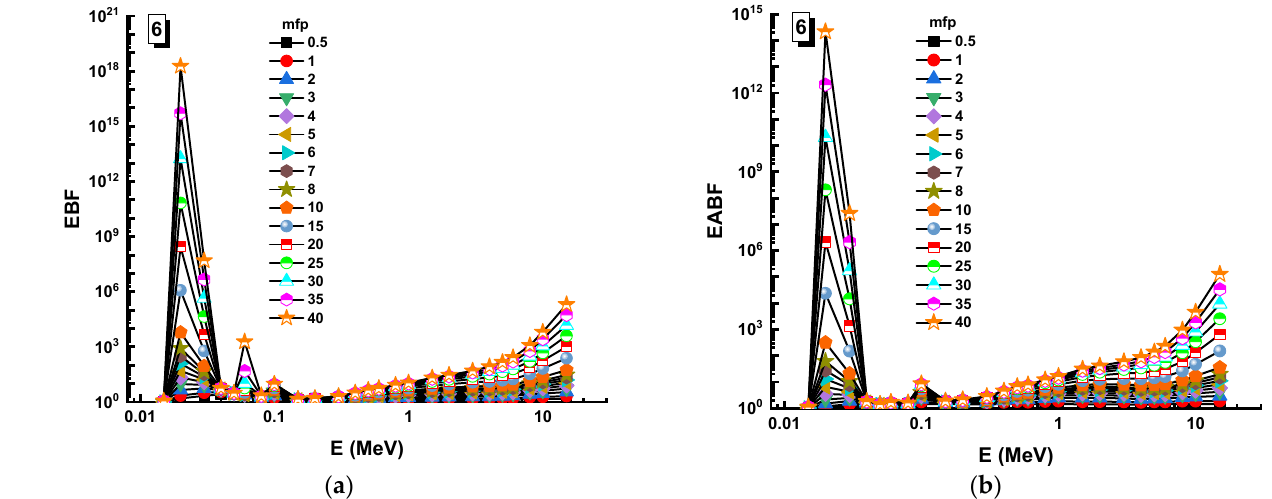
Figure 12. Variation of ( a ) EBF and ( b ) EABF against photon energy for Sample 5.